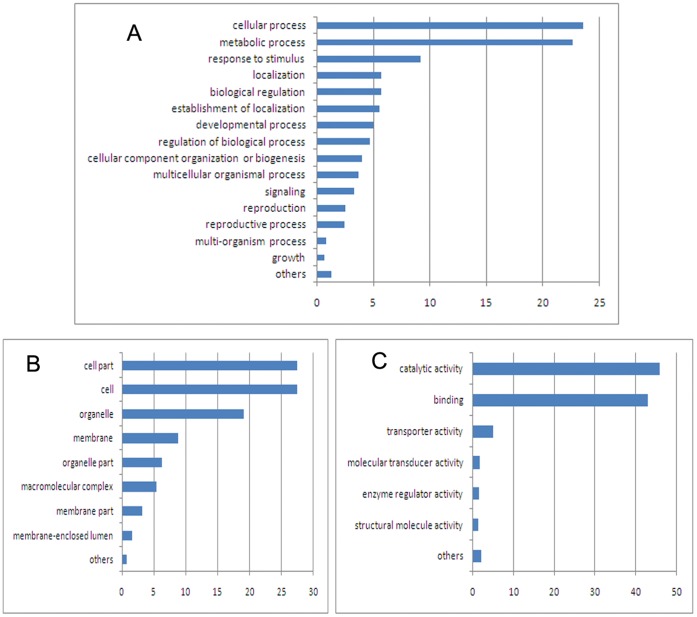
Functional classification of the whole methylated genes.(A) GO: Biological process. (B) Cellular component. (C) GO: Molecular function.